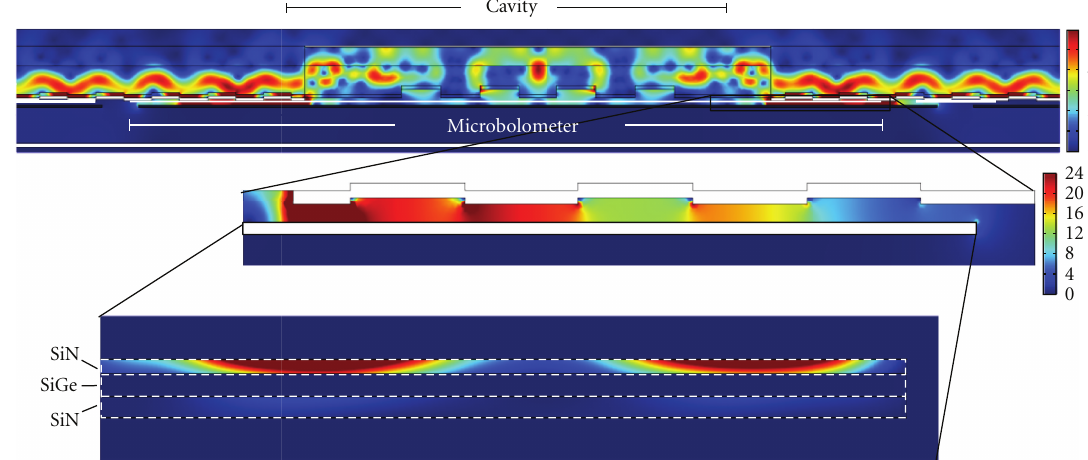
Figure 7: Power flow of the 11 μ m filter after optimizing h MC . First inset is a power flow plot of the overlap region on a di ff erent color scale. Second inset is a plot of ohmic heating in the microbolometer (aspect ratio is expanded vertically by 5x for better visibility).